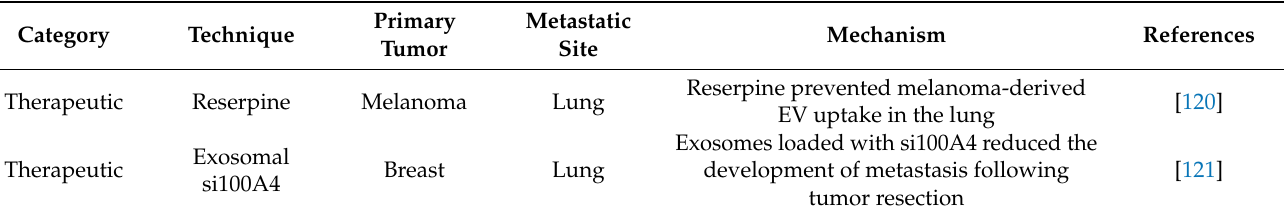
Table 2. Summary of future perspectives regarding the hepatic